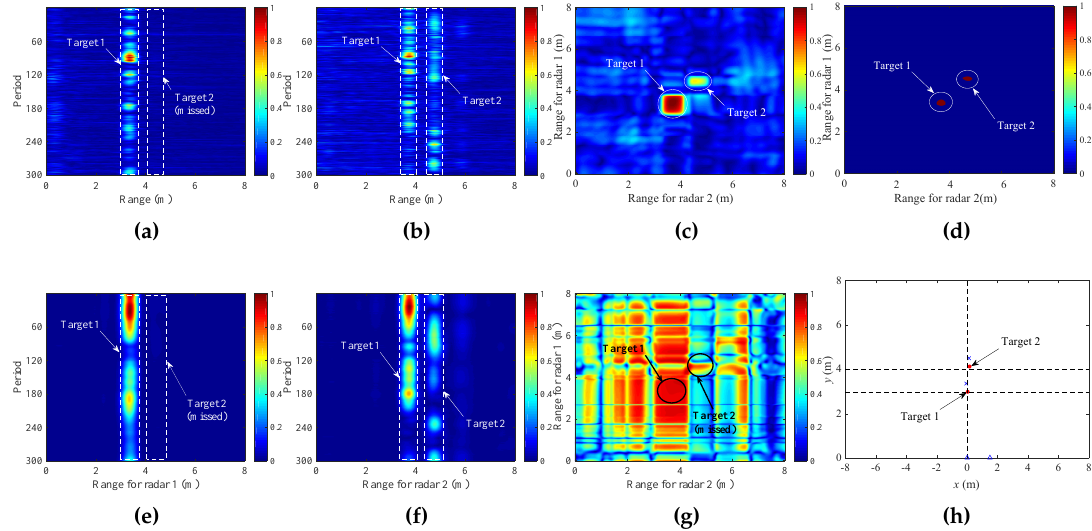
Figure 9. Results of Experiment 1.2: ( a ) range profile plane for Radar 1; ( b ) range profile plane for Radar 2; ( c ) cross-correlation result between ( a , b ); ( d ) CFAR detection result; ( e ) range profile plane of average cancellation for Radar 1; ( f ) range profile plane of average cancellation for Radar 2; ( g ) cross-correlation result between ( e , f ); and ( h ) localization